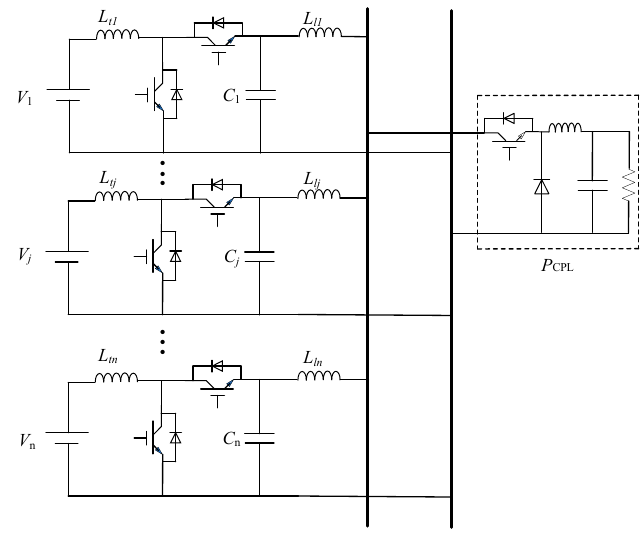
Figure 1. System structure of a DC microgrid.